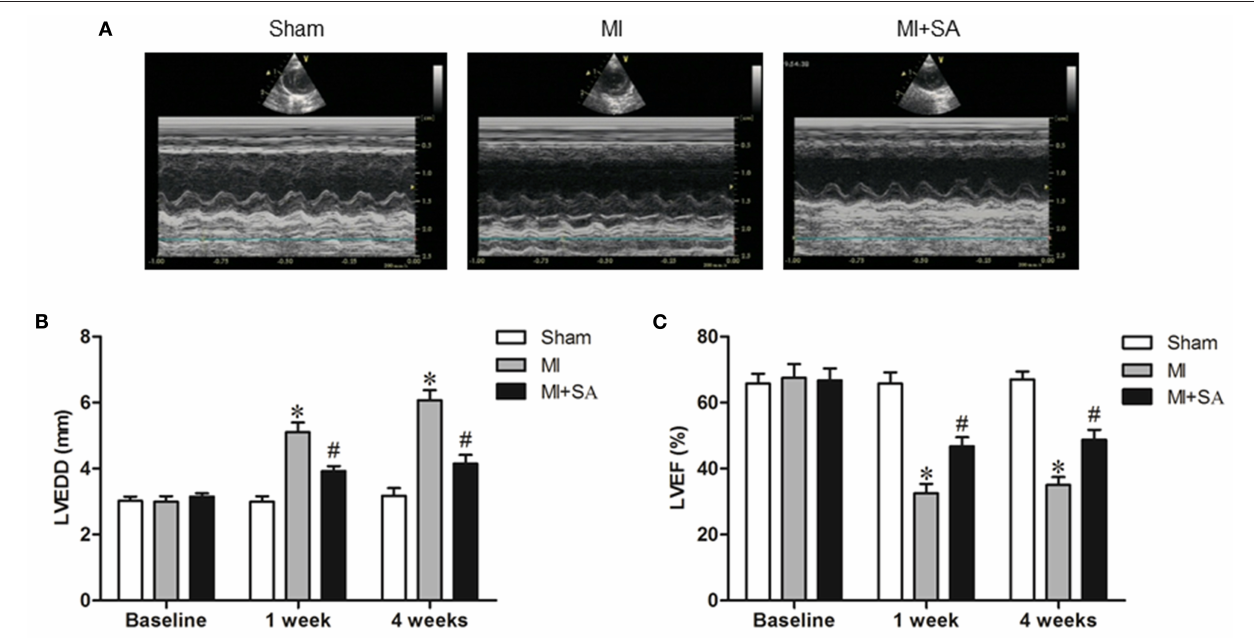
FIGURE 1 | SA ameliorated cardiac dysfunction after MI. (A) Echocardiographic images in the three groups at 1 week after MI. (B,C) SA decreased LVEDD and increased LVEF at 1 week and 4 weeks after MI. * Compared with the sham group, P < 0.05, # Compared with the MI group, P < 0.05, n = 8 in each group.